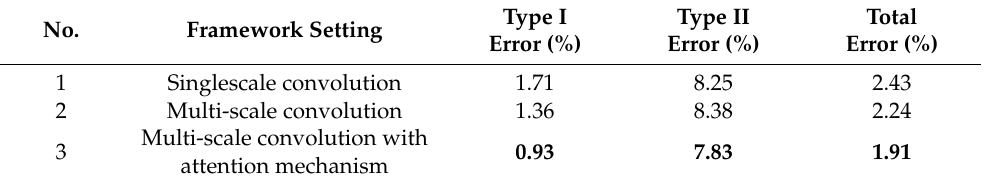
Table 6. Comparison of filtering errors for the ablation experiments upon the ISPRS dataset. No. Framework Setting